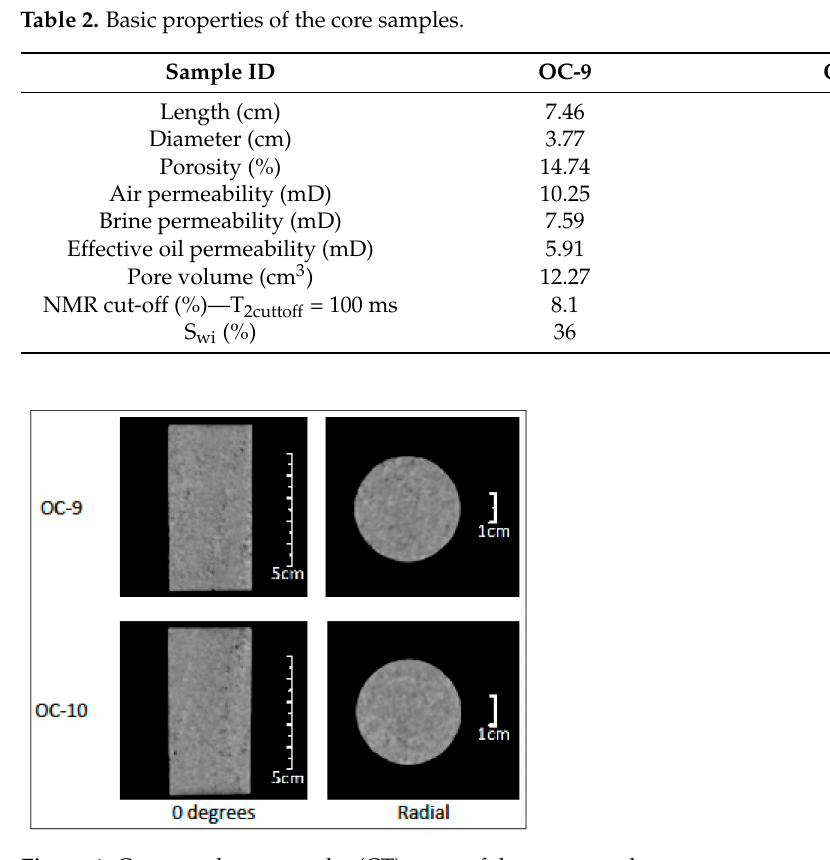
Figure 1. Computed tomography (CT) scans of the core